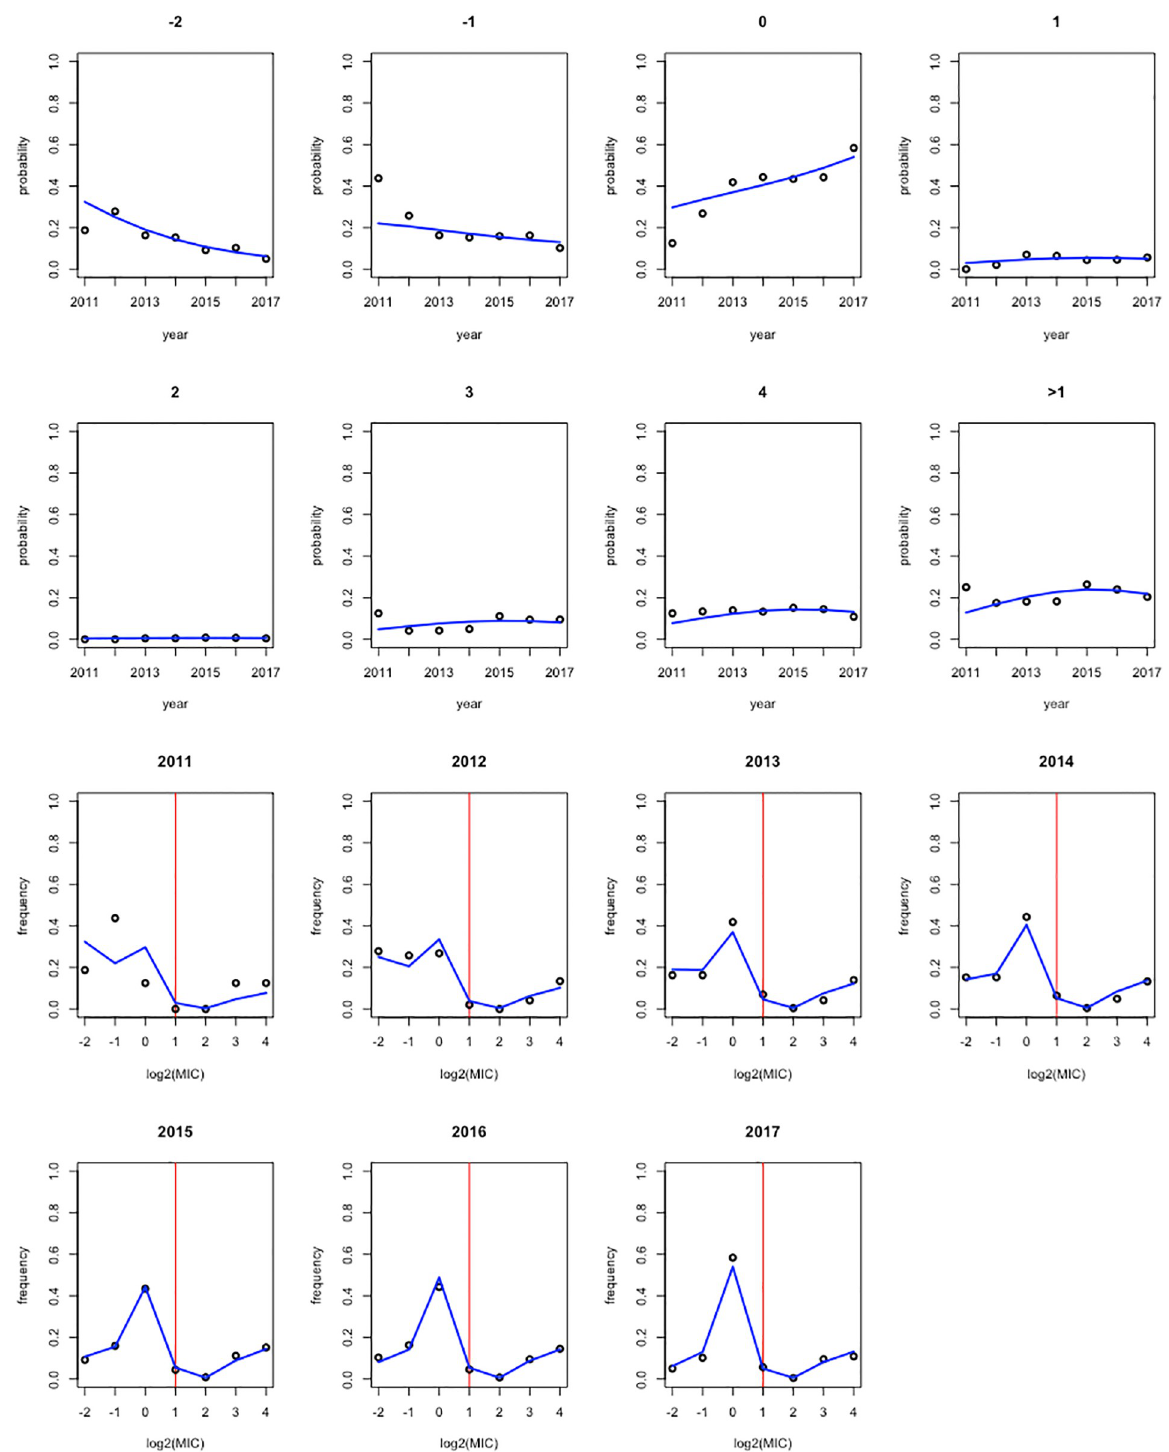
Fig 5. The ISU VDL data. Upper 2 rows: the observed and fitted trend over time using the best fitting model 7, for the probability for each of the 7 MIC values (on log2-scale), and, in the right lower panel, for the proportion resistant > 1 (1 being the threshold). Lower 2 rows: the observed and fitted MIC distribution using the best fitting model 7, for each year. The vertical red line refers to the threshold category.